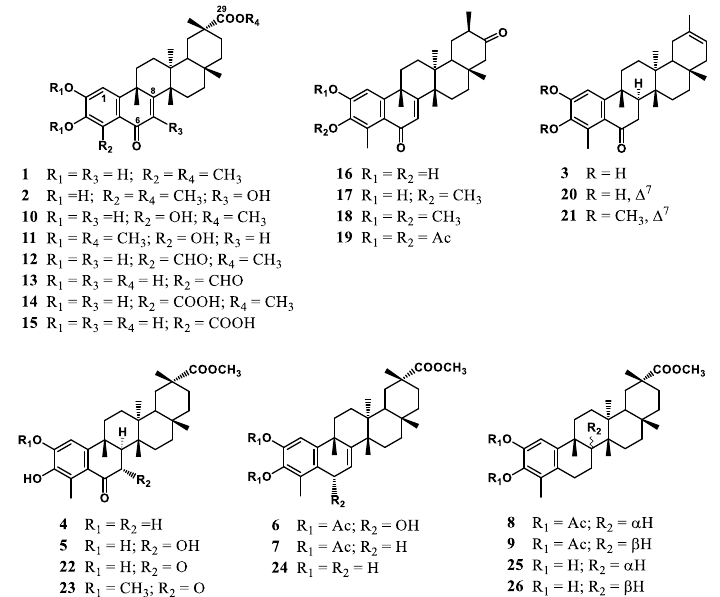
Figure 2. Natural and derivatives phenolic nor-triterpenes included in the SAR studies. SAR: structure– activity relationship.